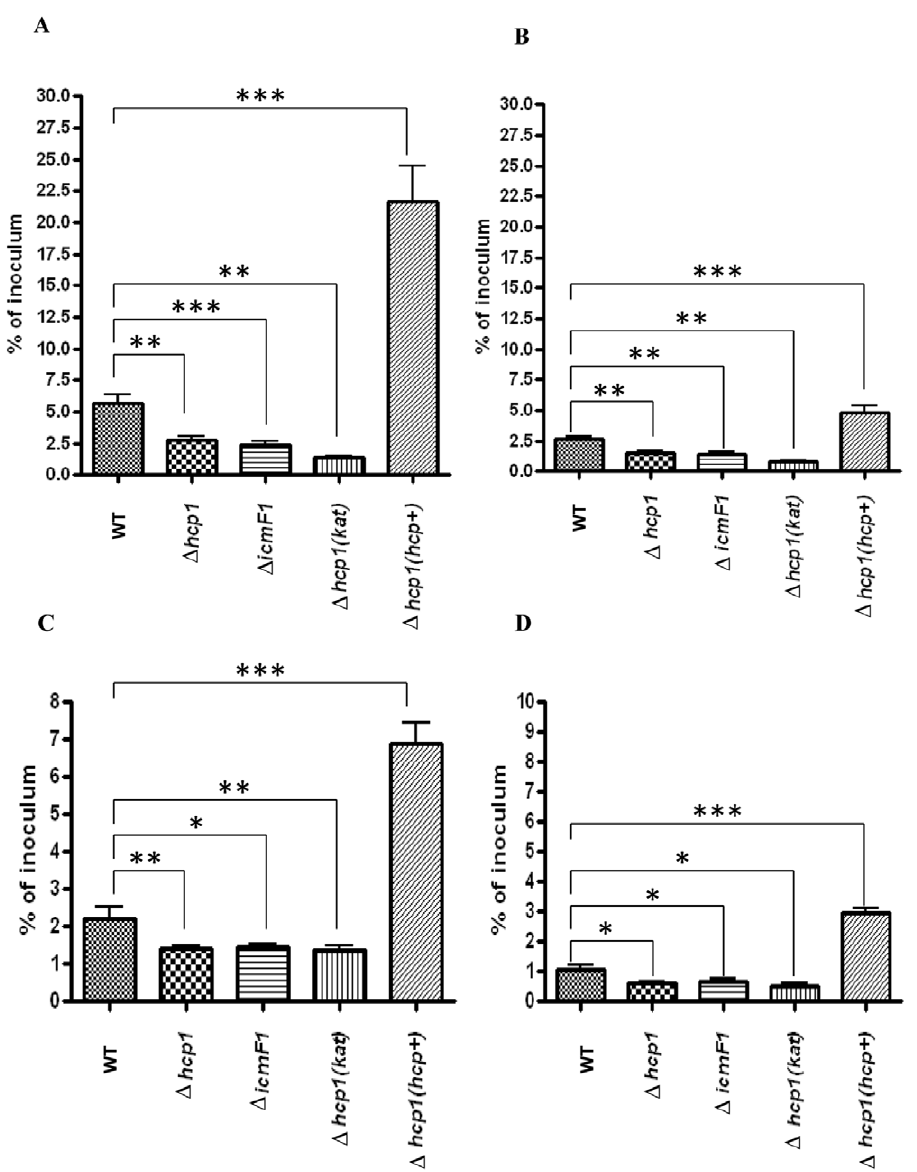
Figure 7. Adhesion and invasion efficacy of WT C.jejuni , the D hcp1 mutant, the D icmF1 mutant, and the complemented D hcp1 strain, D hcp1 ( hcp + ), in human T84 colonic epithelial and RAW 267.4 macrophage cell lines. (A) T84 adhesion efficacy, B) T84 invasion efficacy,